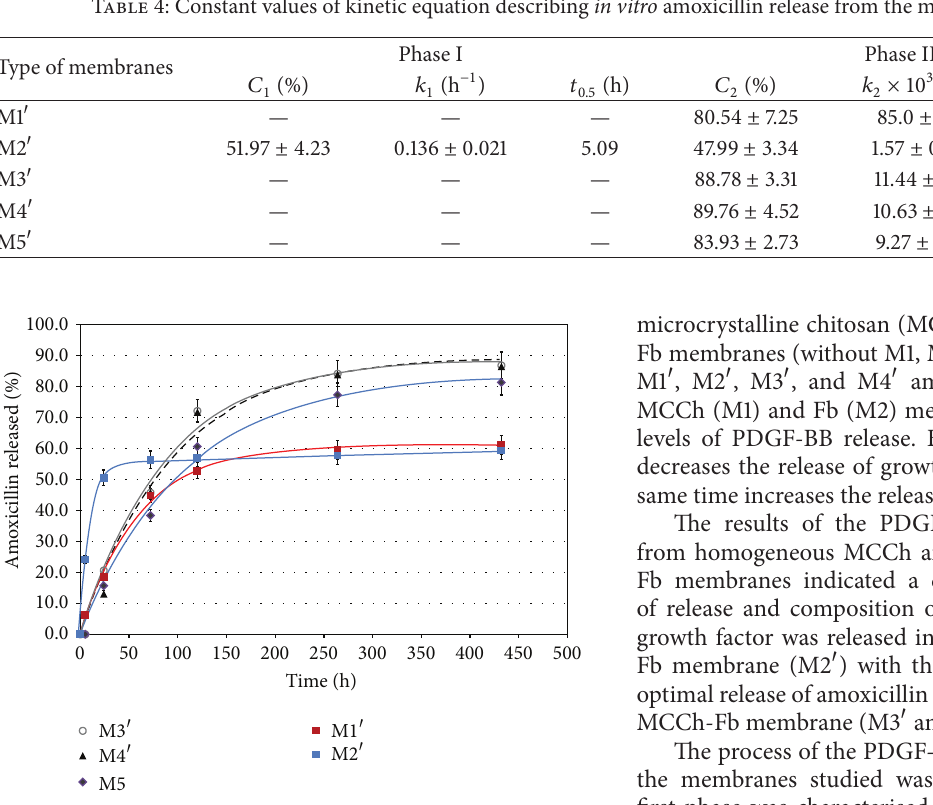
Figure 10: Release profile of amoxicillin from membrane systems: M1 󸀠 MCCh, M2 󸀠 Fb, and M3 󸀠 MCCh:Fb = 2: 1, M4 󸀠 MCCh:Fb = 1:1, and M5 󸀠 MCCh:Fb = 1: